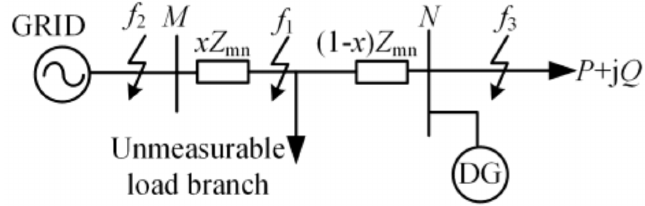
Figure 1. Schematic diagram of the simple active distribution network.